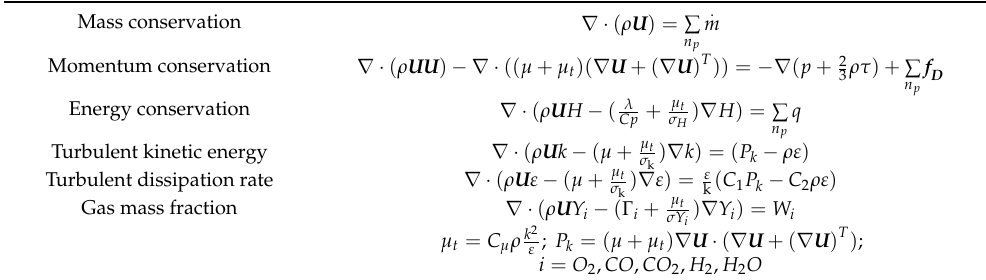
Table 1. Governing equations of gas phase in the model.